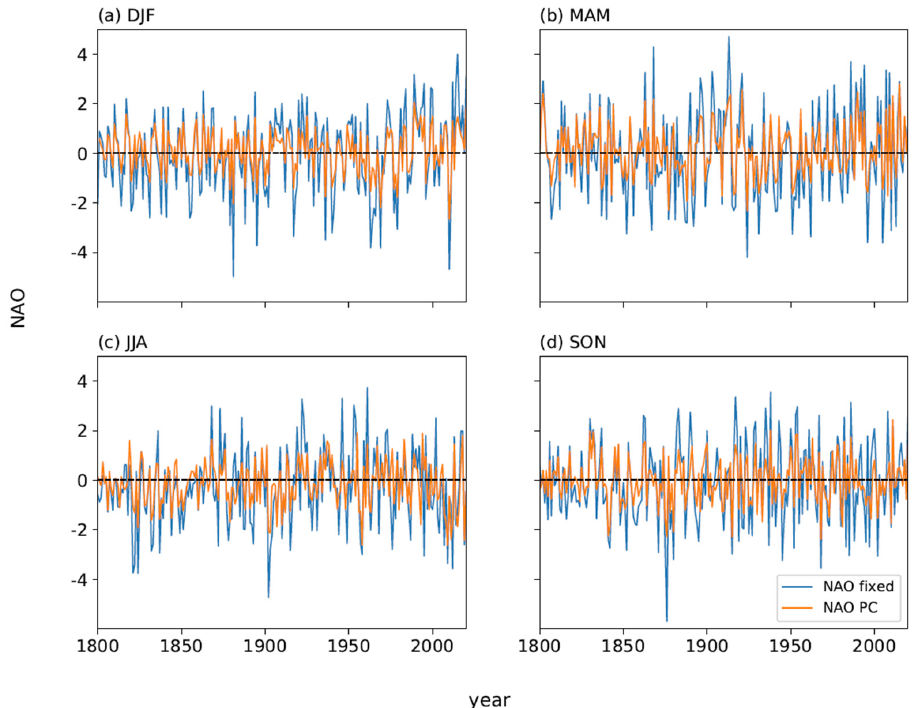
Figure 7. Seasonal series for 1800–2020 of NAO Fixed and NAO PC for ( a ) winter (DJF), ( b ) spring (MAM), ( c ) summer (JJA) and ( d ) autumn (SON).